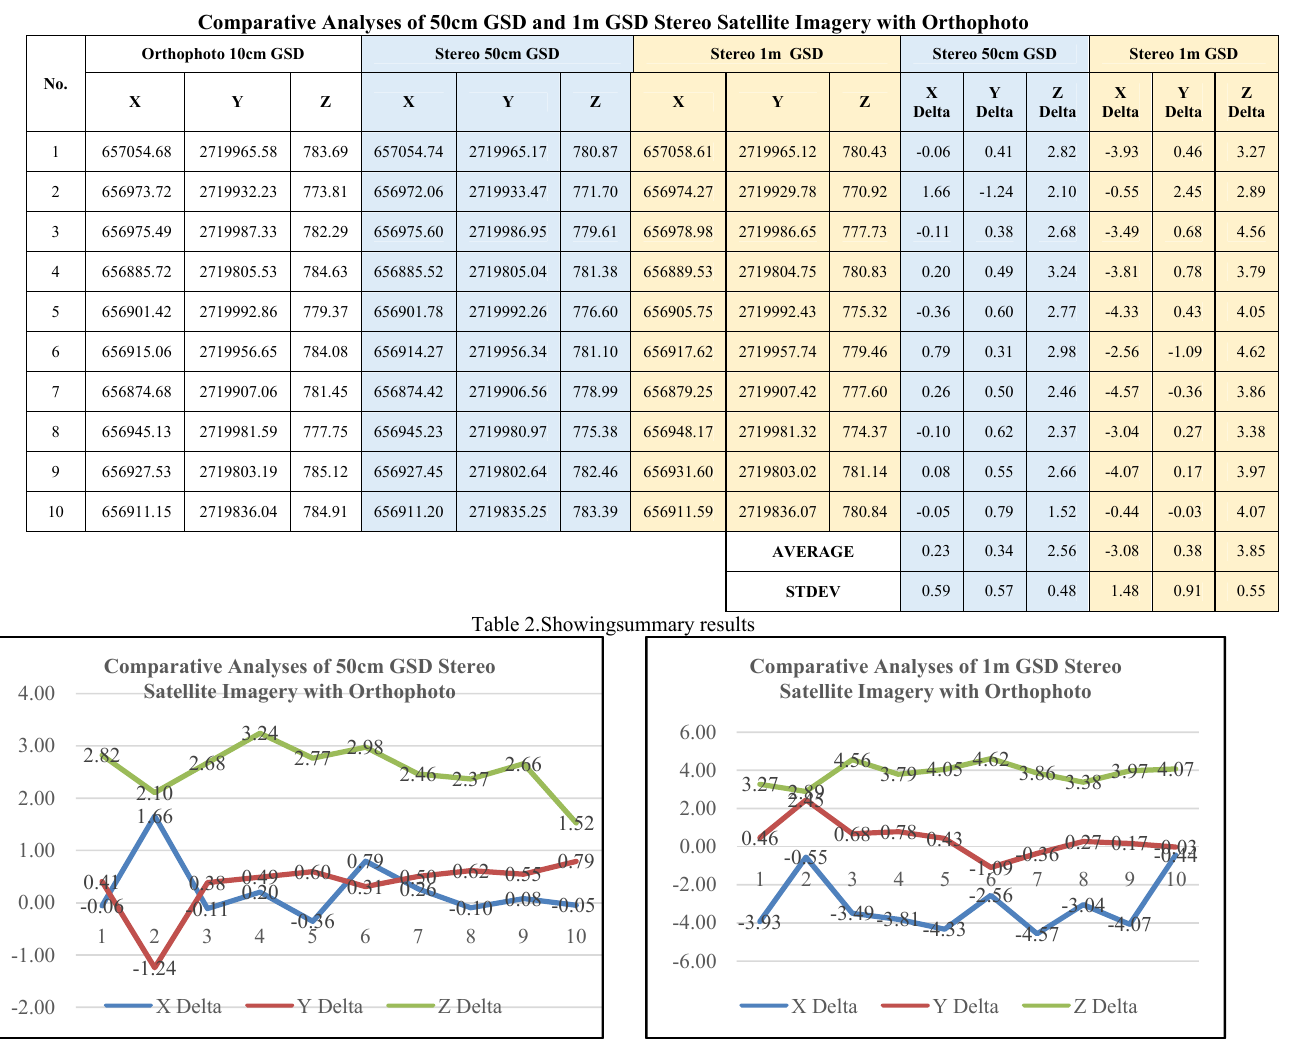
Figure 2 Comparative analyses of data digitized from 1m GSD Stereo Satellite Imagery with 10cm GSD Orthophoto